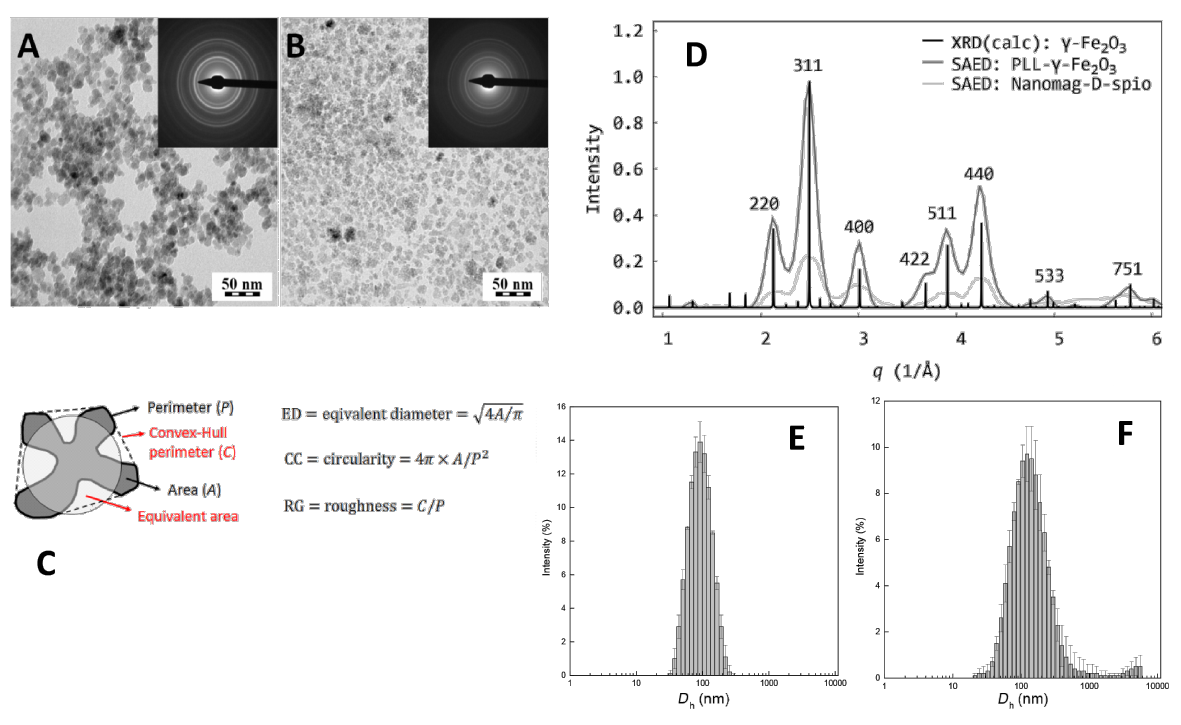
Figure 1: Transmission electron micrographs micrographs of (A) PLL- γ -Fe 2 O 3 and (B) nanomag ® -D-spio nanoparticles. Insets show the correspond- ing electron diffraction patterns. (C) The nanoparticle morphology was characterized by measuring morphological descriptors. Area ( A ) and perimeter ( P ) of the analyzed particles were determined by counting the pixels using an image analysis software. Convex-Hull perimeter ( C ) and equivalent area were derived auxiliary descriptors. Key morphological descriptors were equivalent diameter (ED), circularity (CC) and roughness (RG). ED deter- mined a diameter of a circle with the same area as the measured particle. CC equaled to 1 for circles; all other shapes had CC < 1. RG of smooth objects was 1, whereas the rough objects had RG < 1. (D) Experimental selected area electron diffraction (SAED) patterns of PLL- γ -Fe 2 O 3 and nanomag ® -D-spio were compared to calculated X-ray diffraction (XRD) pattern of γ -Fe 2 O 3 . (E,F) Size distribution by intensity of uncoated (E) and PLL-coated (F) γ -Fe 2 O 3